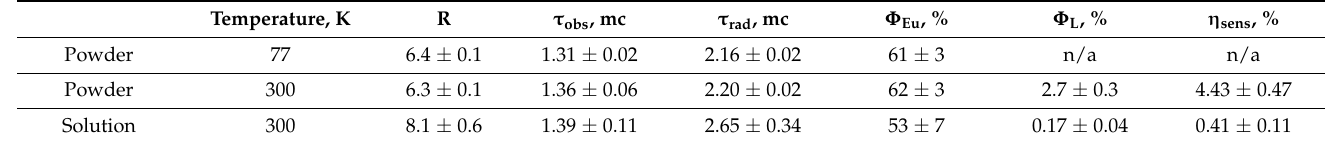
Table 2. Luminescent characteristics of the europium